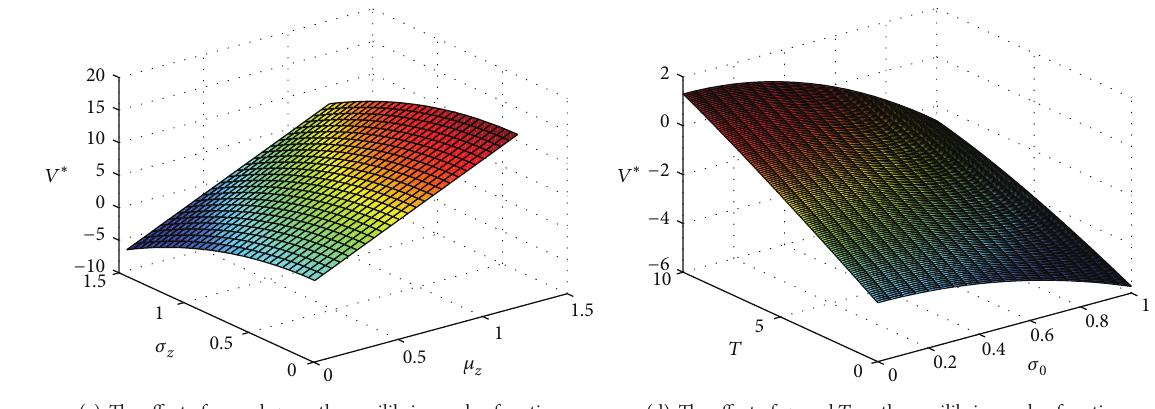
(d) The effect of 𝜎 0 and 𝑇 on the equilibrium value function Figure 5: The effect of parameters on the equilibrium value